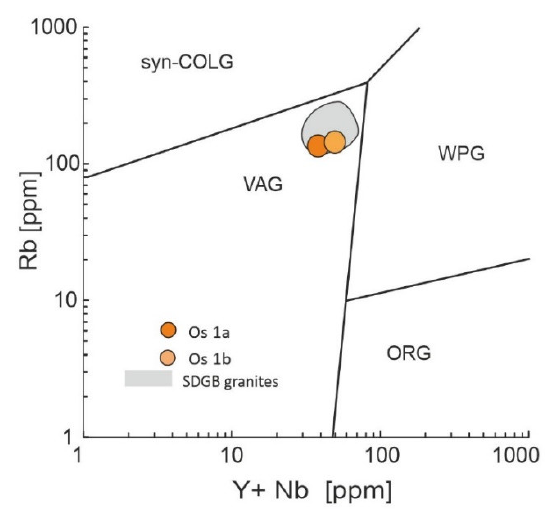
Figure 6. Plot of the granitoid from Osielec stream on the discrimination diagram of [49]: VAG— volcanic arc granites; syn-COLG—syn-collisional granites, WPG—within-plate granites, ORG— ocean ridge granites.